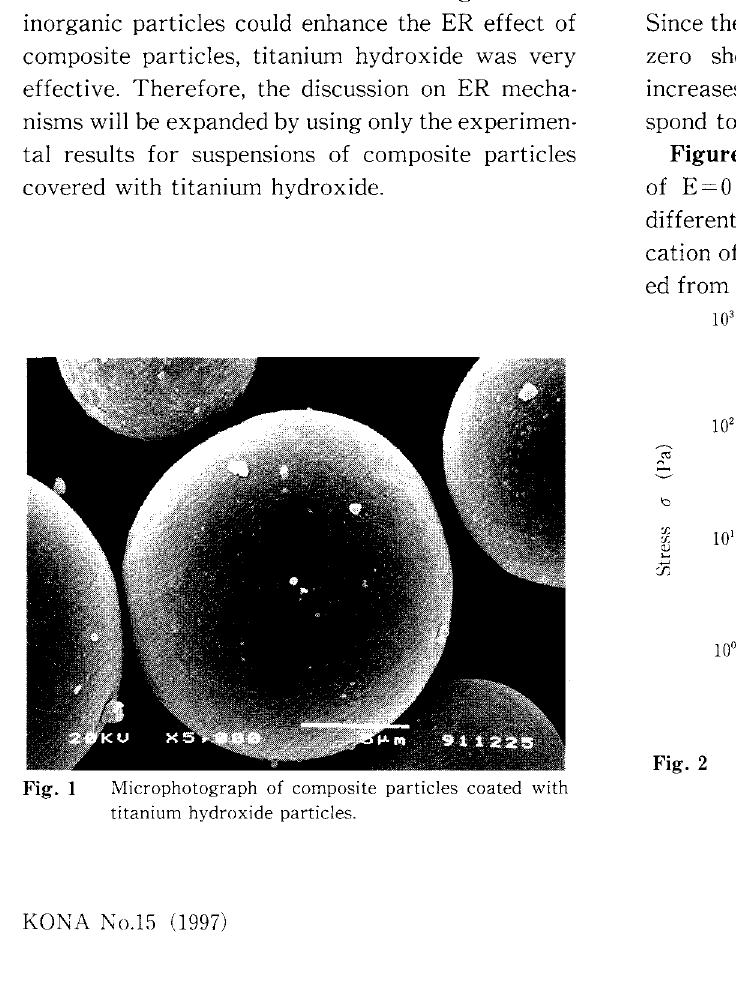
Flow curves for 30wt% suspension in different electric fields: (Q)O, ((D)O.S, (8)1.0, ((t)l.5, and (w) 2.0 kVmm-